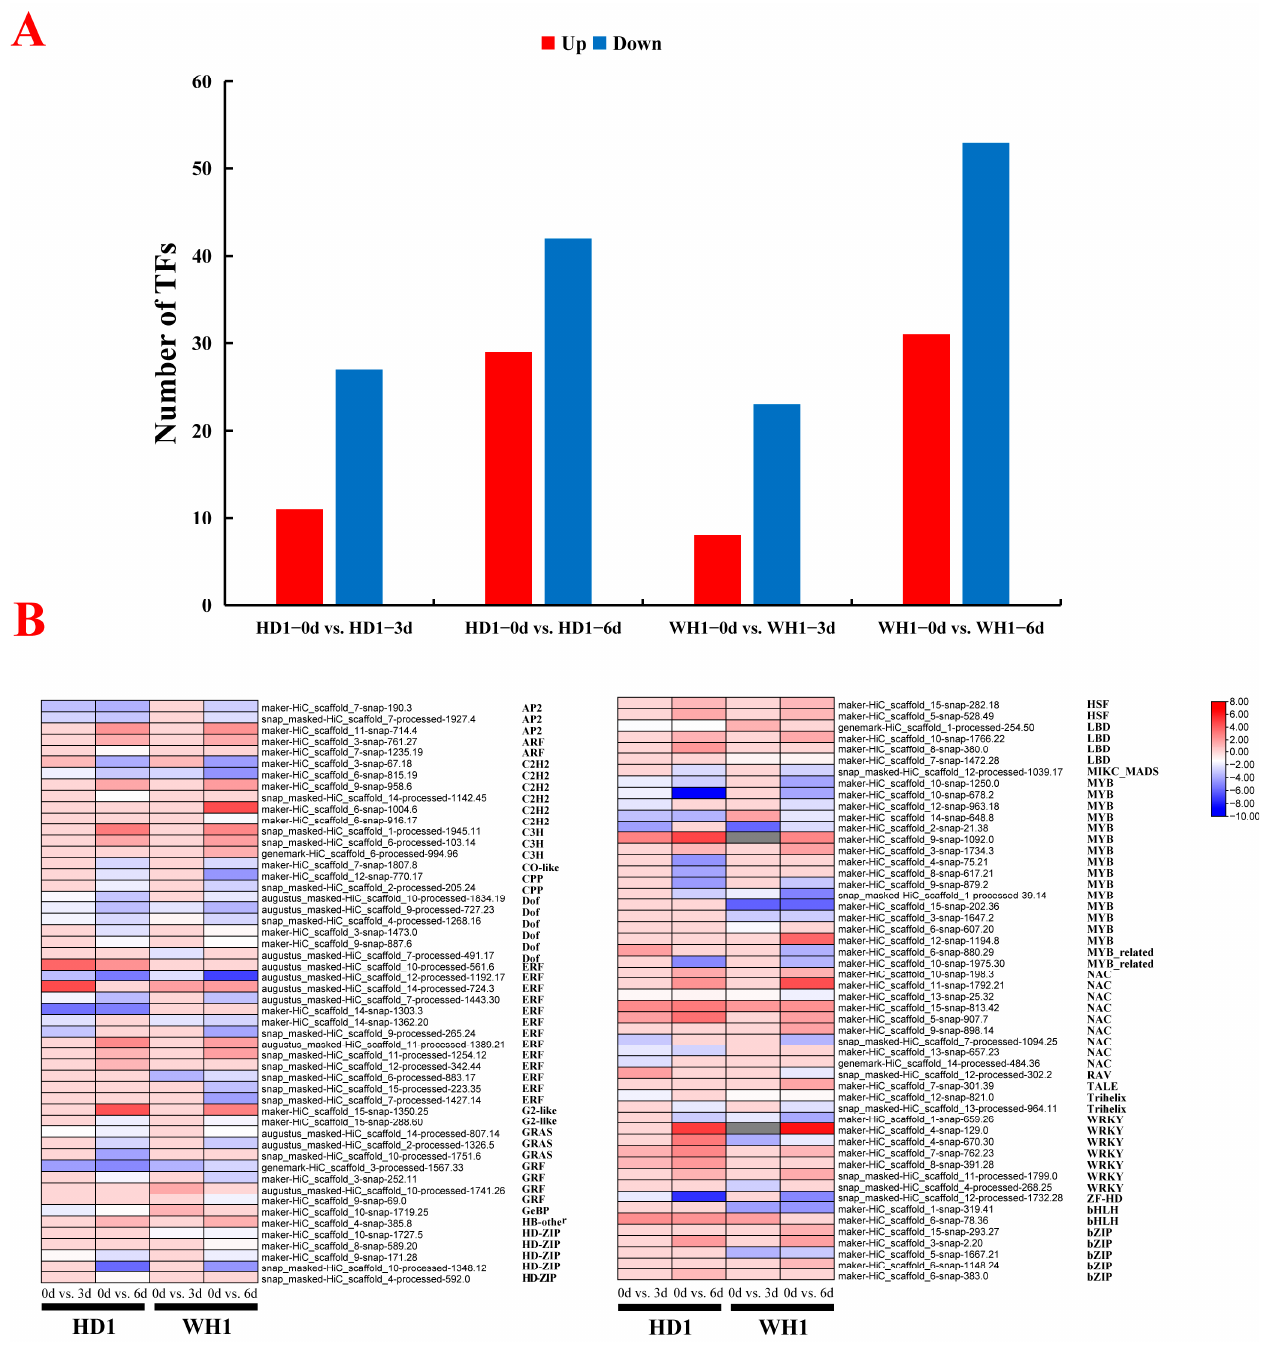
Figure 9. Transcription factor (TF) analysis of C. vietnamensis leaves under PEG stress. ( A ): The number of TF of two C. vietnamensis cultivars compared between different groups. ( B ): Heatmap of TF-related gene expression. Blocks from left to right indicate the TF from comparisons of HD1-0d vs. HD1-3d, HD1-0d vs. HD1-6d, WH1-0d vs. WH1-3d, and WH1-0d vs. WH1-6d. The value is the log2(fold change) value of each sample in each group.